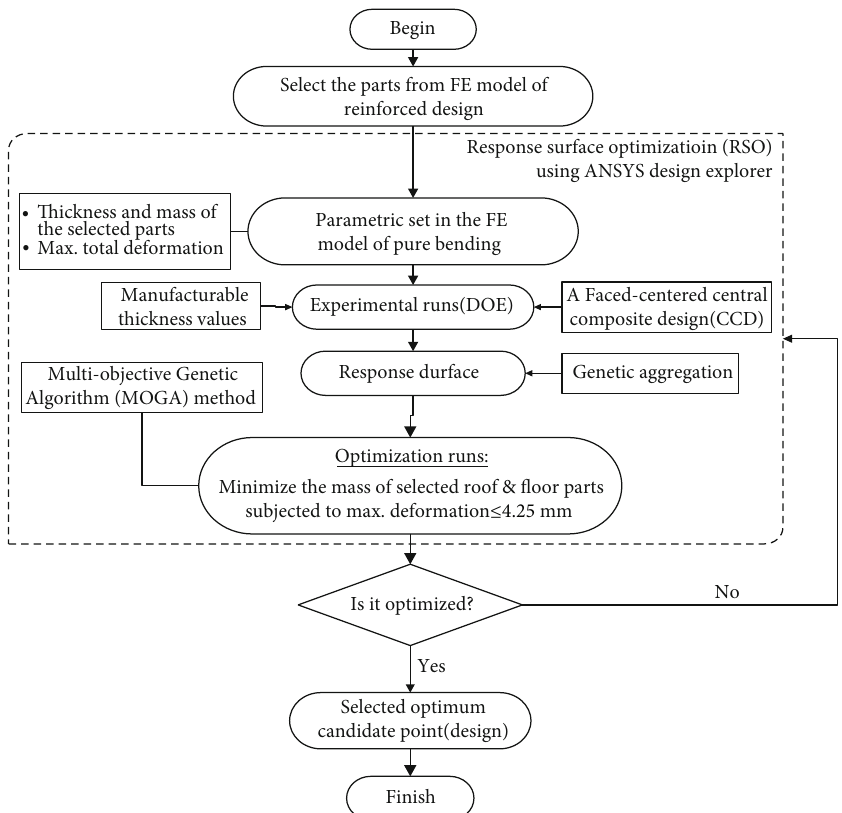
Figure 9: Response surface optimization process via ANSYS